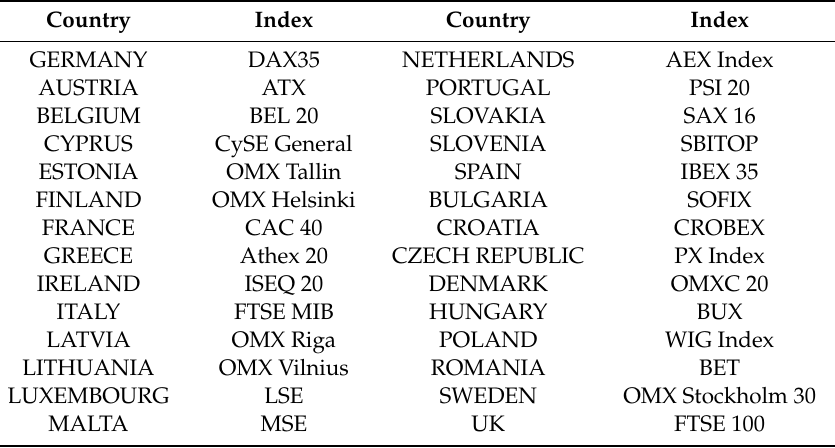
Table 1. Stock markets used in the